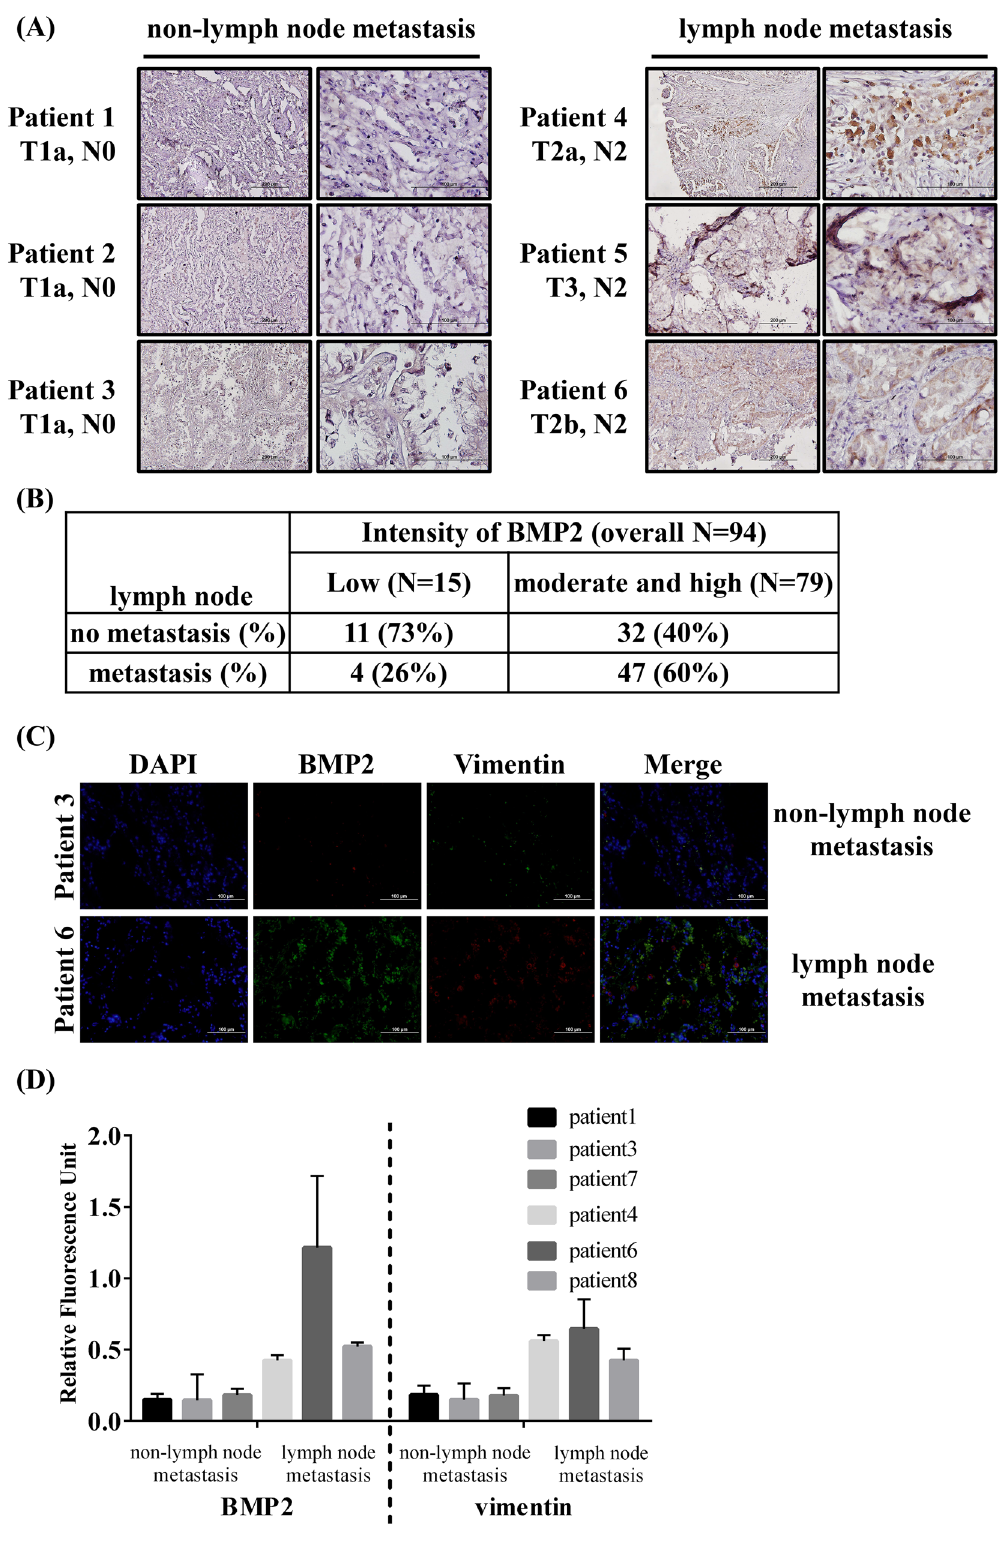
Figure 1. BMP2 is highly expressed in lung adenocarcinoma patients with lymph node metastasis. ( A ) The representative BMP2 immunohistochemistry (IHC) images in tissue samples from patients with and without lymph node metastasis. Slides were observed under 4 × and 40 × magnification. ( B ) BMP2 IHC was analyzed in samples derived from 94 patients with lung cancer. Significance was determined by Fisher’s exact test ( p = 0.025). ( C ) Representative images of BMP2 and Vimentin immunofluorescence in samples derived from patients with and without lymph node metastasis. Slides were observed under 10 × magnification. ( D ) Quantitative analysis of fluorescence intensity of BMP2 and Vimentin. Analysis of fluorescence intensity was done at the original magnification using ImageJ software. At least three fields were